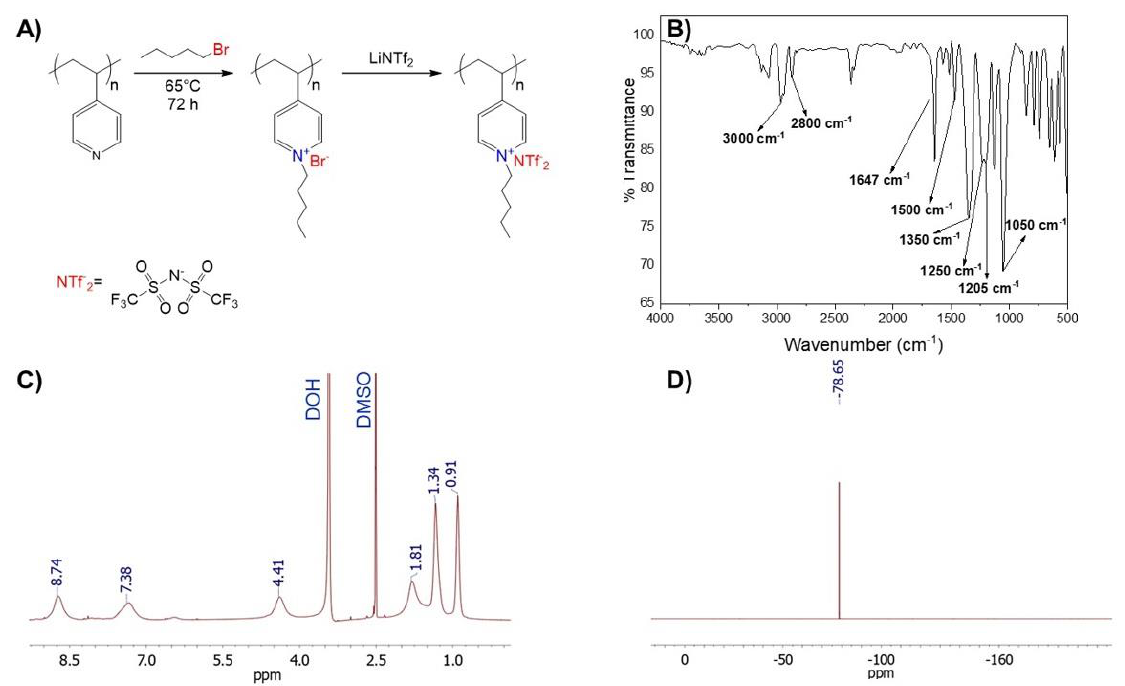
Figure 1. ( A ) Scheme of synthesis PP4VPyNTf 2 − poly(ionic liquid) synthesis; ( B ) FT-IR spectrum and ( C ) 1 H- and ( D ) 19 F- NMR spectra of the poly(ionic liquid).